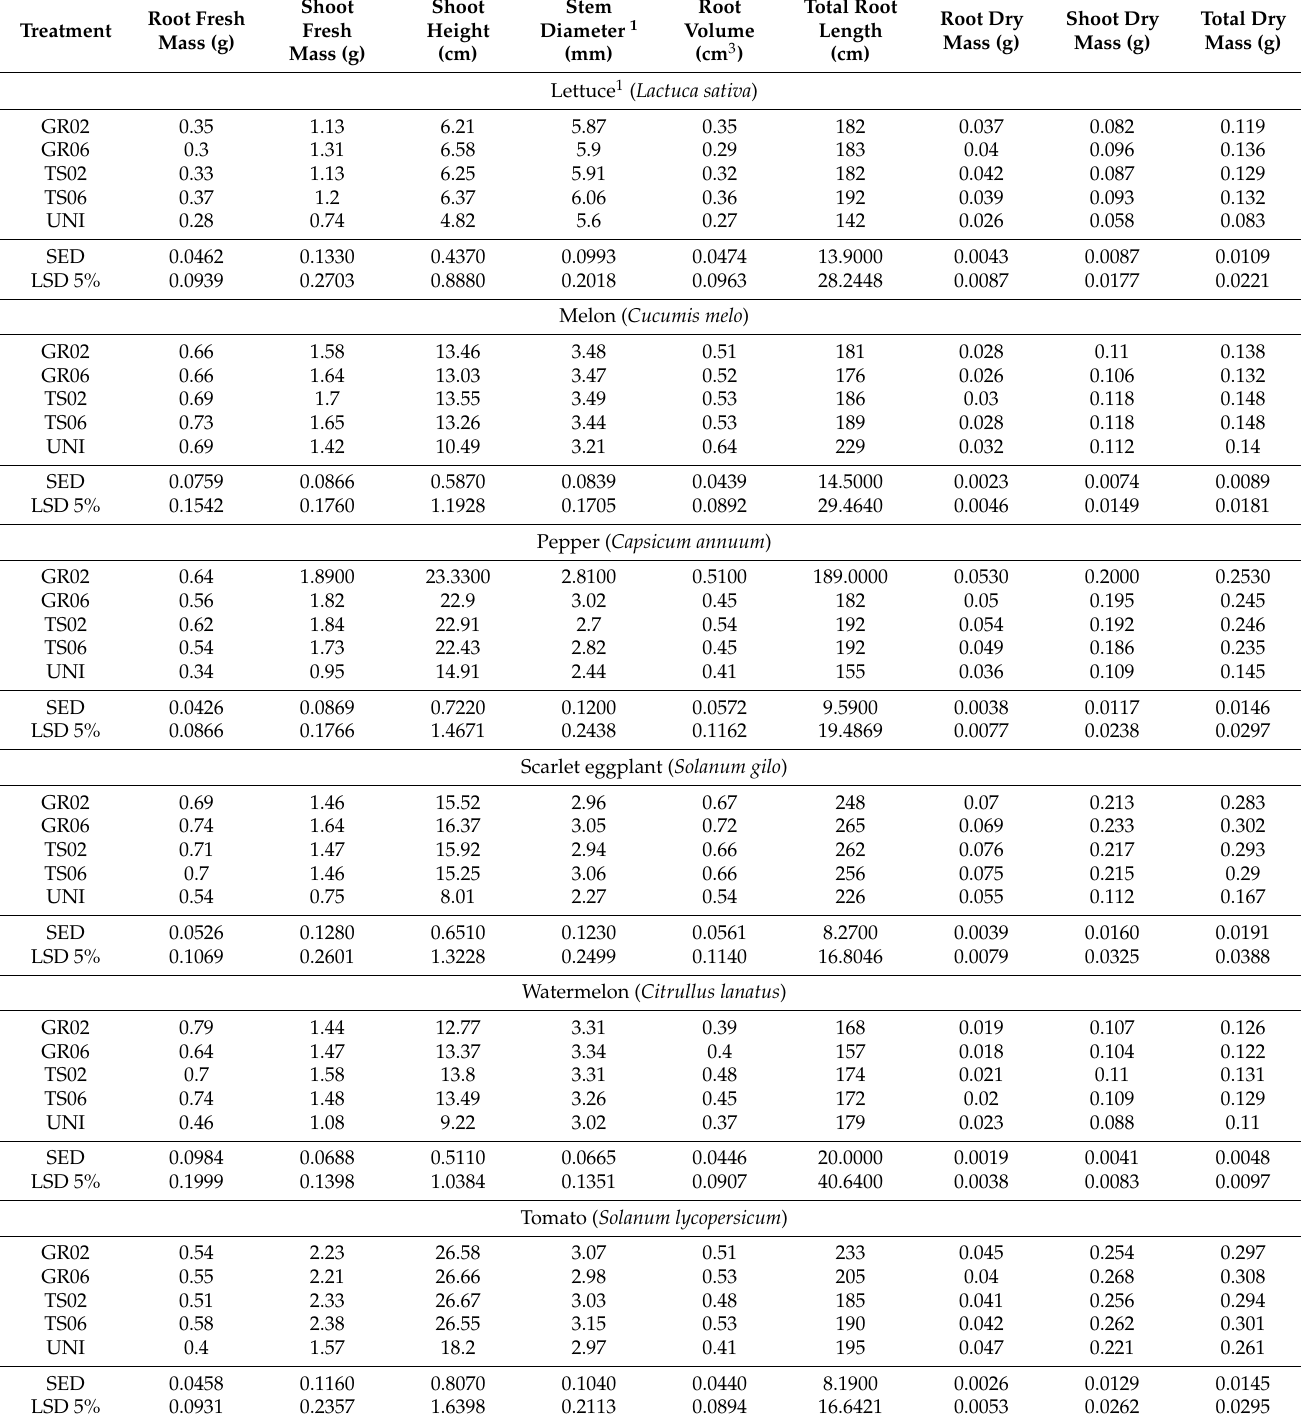
Table 2. Effect of inoculation method and dose of A. niger FS1 on plant growth parameters of vegetable